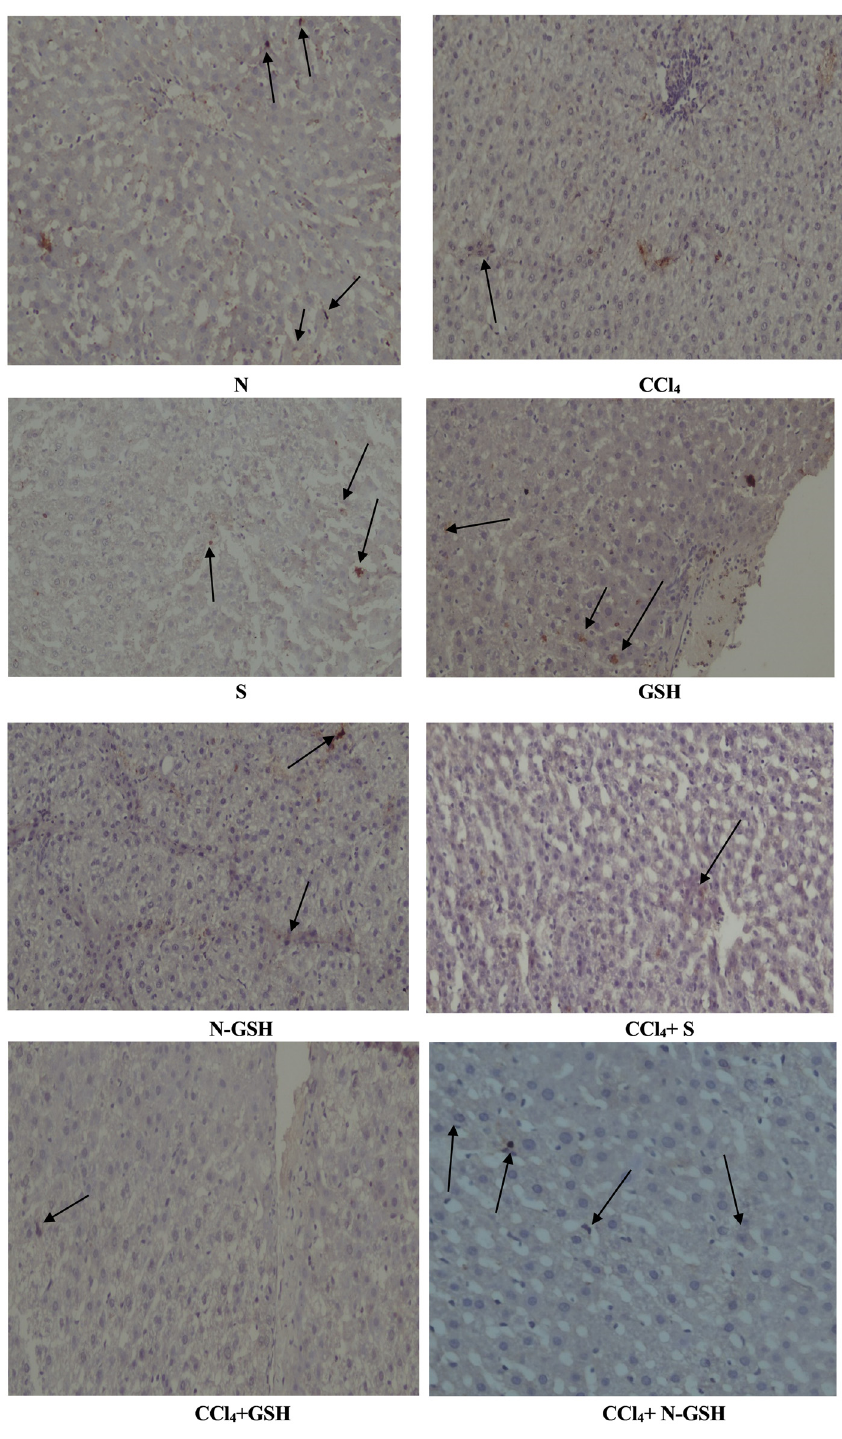
Figure 7: Immunohistochemistry results of Bcl - 2 on hepatic tissues of N, normal rats; CCl 4 , treated rats; S, silymarin - treated rats; GSH, glutathione - treated rats; N - GSH, nano - glutathione - treated rats; CCl 4 + S, CCl 4 + silymarin - treated rats; CCl 4 + GSH, CCl 4 + glutathione - treated rats; and CCl 4 + N - GSH, CCl 4 + nanoglutathione - treated